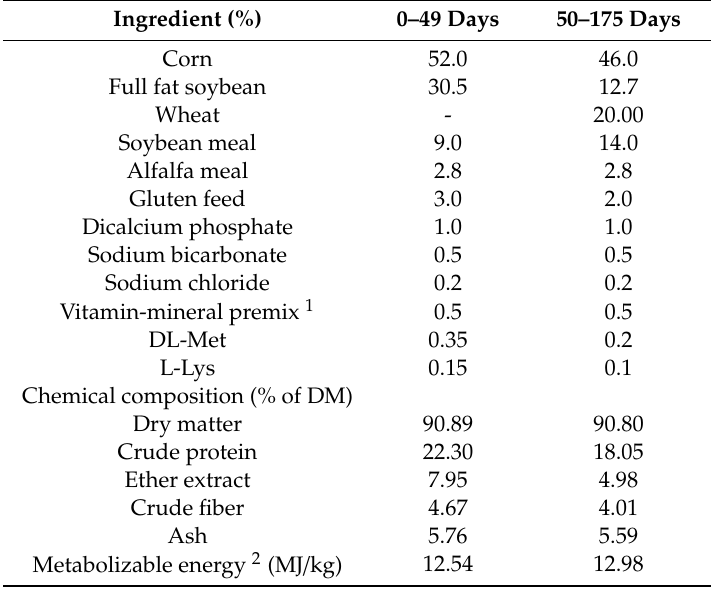
Table 1. Ingredients and chemical composition of basal